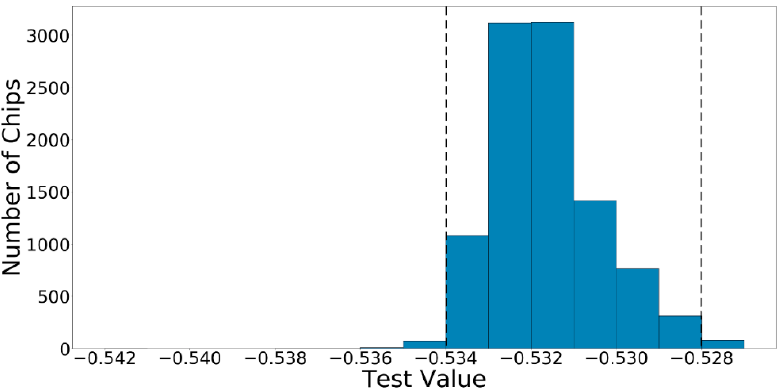
Figure 6. The results obtained using one test item.